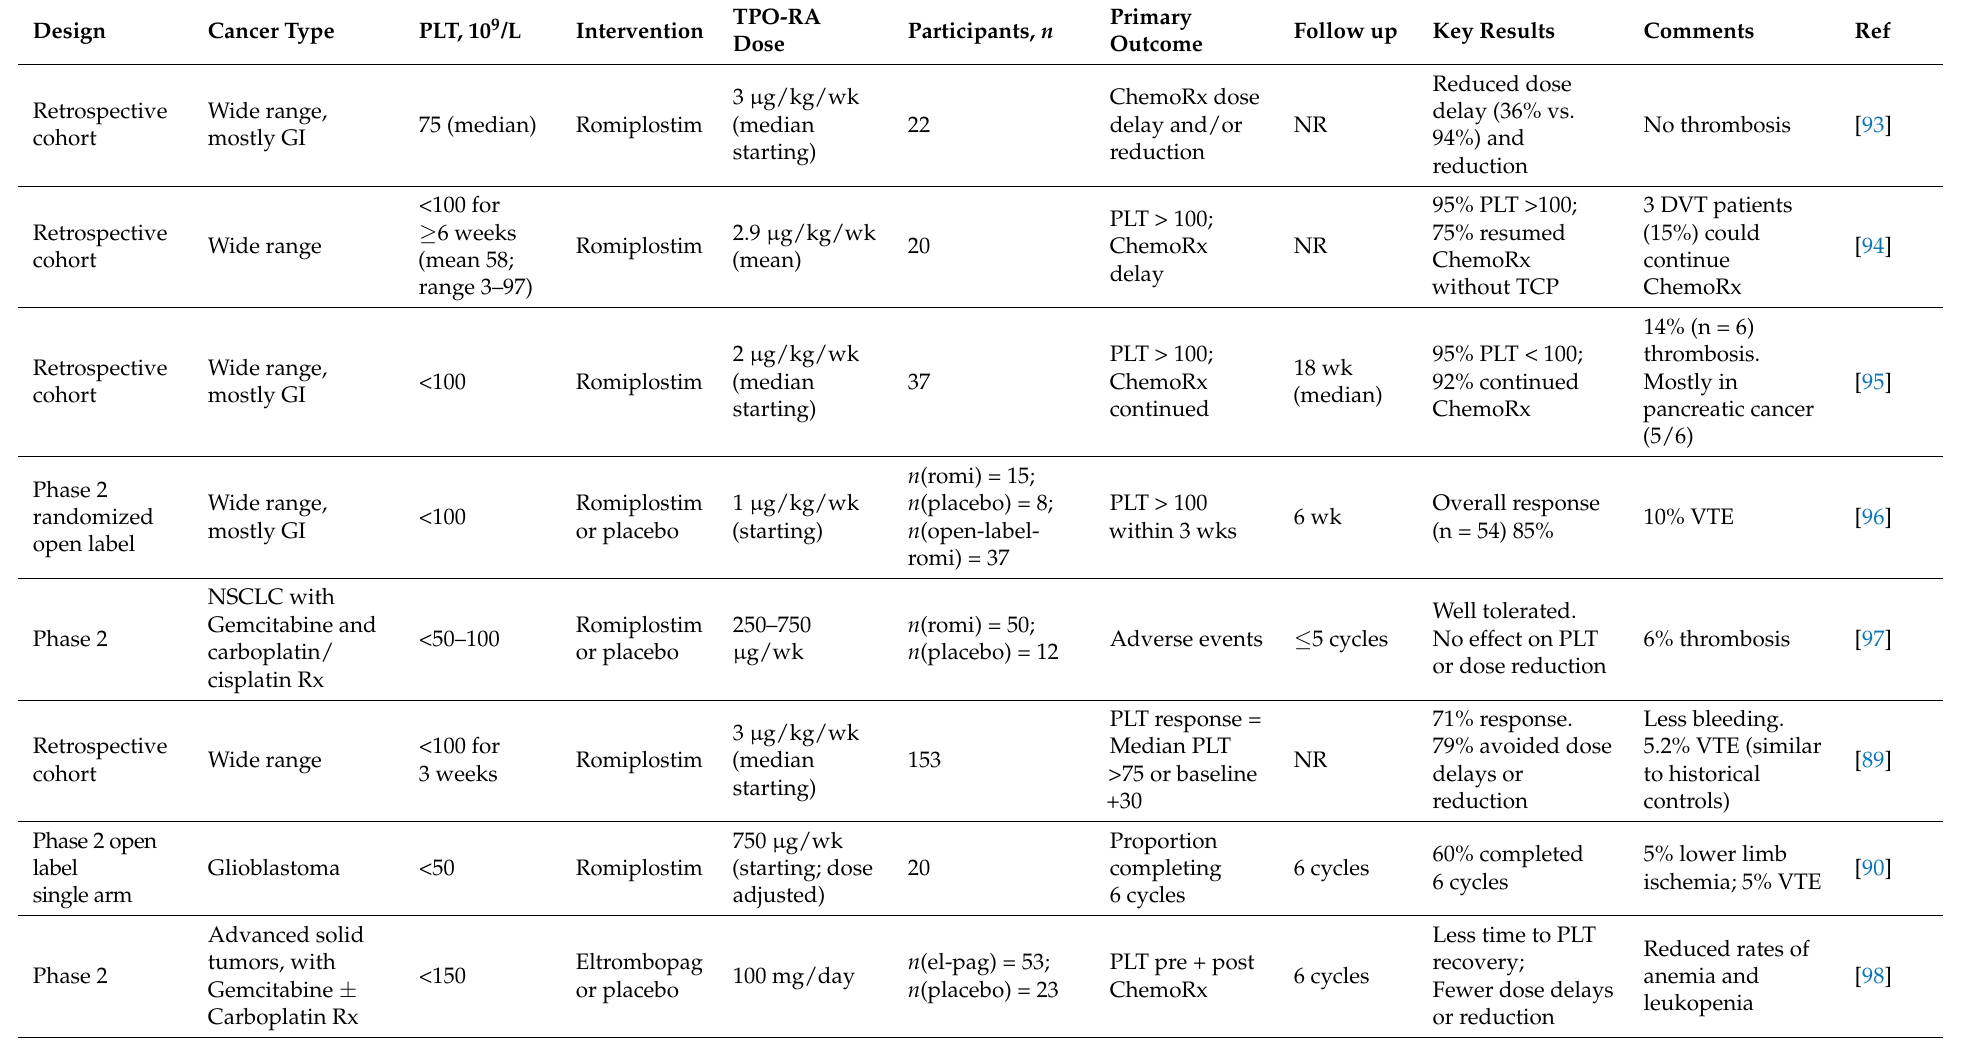
Table 3. Selected studies on TPO-RAs for preventing or treating CIT in solid